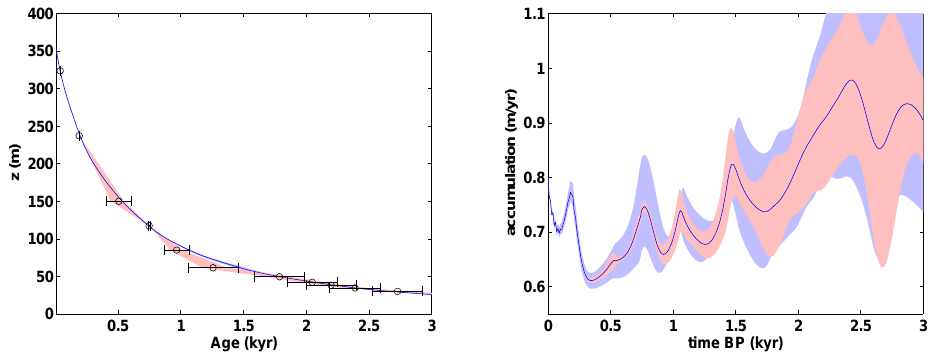
Figure 6. Sensitivity analysis to uncertainty in chronology (red) and shape function η (blue). The uncertainty in chronology is assumed to follow a normal distribution. The uncertainty in the shape function η is represented by the range 2 ≤ n ≤ 5 for the rheological index in the Glen flow law.